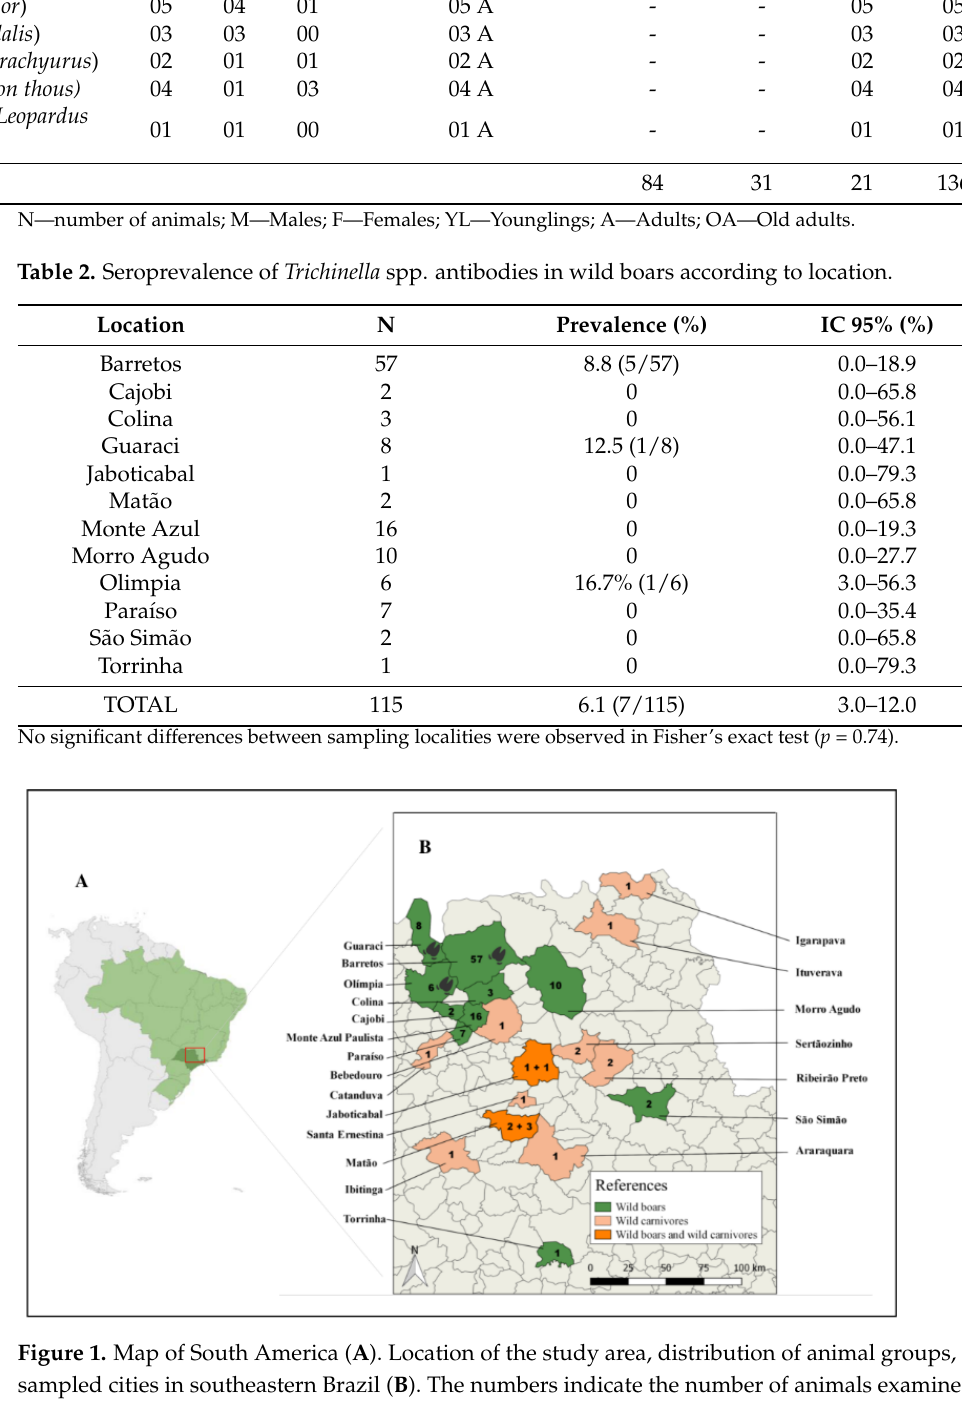
Figure 1. Map of South America ( A ). Location of the study area, distribution of animal groups, and sampled cities in southeastern Brazil ( B ). The numbers indicate the number of animals examined in each city: only wild boars, wild boars and wild carnivores, and only wild carnivores. The symbol